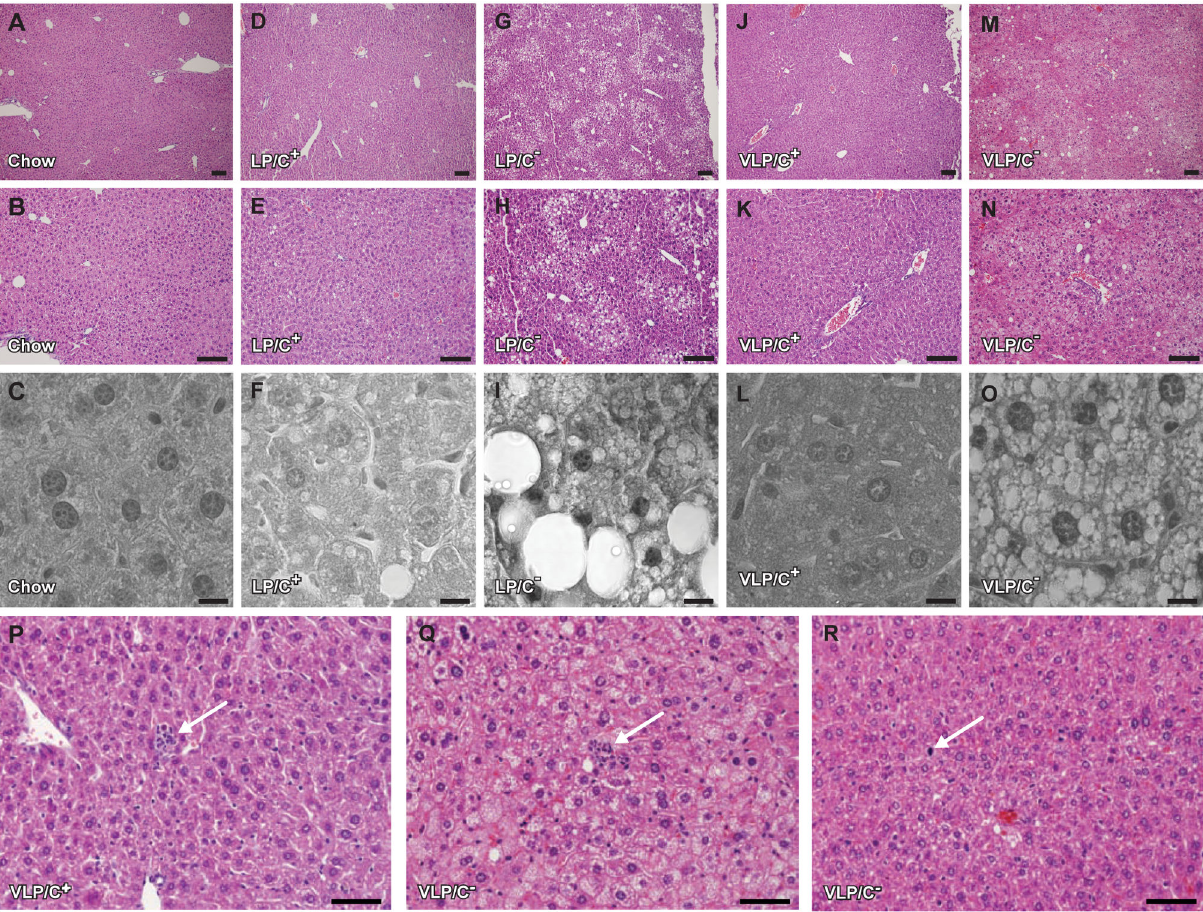
Figure 3. Intrahepatic triglyceride content and hepatic histopathology in mice fed very high fat, low protein, very low carbohydrate diets. Hepatic histology in mice maintained for 6 weeks on ( A – C ) standard chow; ( D – F ) LP/C + diet, which caused very small amounts of mixed large and small droplet steatosis in hepatocytes restricted to zone 2 (a representative example of zone 2 is displayed in panel F ), and no inflammation; ( G – I ) LP/C - diet, which caused mixed large and small droplet macrovesicular steatosis in a zone 2 distribution (a representative example of zone 2 is displayed in panel I ); ( J – L ) VLP/C + diet, which exhibited small lipid droplets only at higher power; ( M – O ) VLP/C - diet, which caused diffuse steatosis that is predominantly small and microvesicular with some macrovesicular droplets. Numerous clusters of inflammatory cells, some of which are likely associated with necrotic hepatocytes, were observed. Livers of mice fed both VLP/C + ( P ) and VLP/C - ( Q ) exhibit inflammatory foci (arrows). ( R ) Only in livers from VLP/C - -fed were mitotic figures observed (arrow). Scale bars: ( A, B, D, E, G, H, J, K, M, N , lower power images taken with standard light microscopy, original magnification at 10X or 20X), 100 μm; ( C, F, I, L, O , higher power images taken with confocal microscopy, original magnification at 80X), 10 μm; ( P, Q, R , medium power images taken with standard light